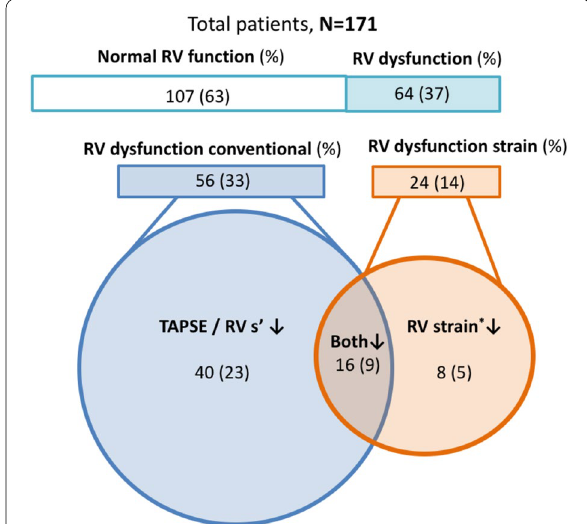
Fig. 2 Venn diagram conventional RV CCE measurements and RV strain indicating RV dysfunction. *Indicating TDI-derived RV global longitudinal peak strain (RV4CSL) and RV free wall longitudinal peak strain